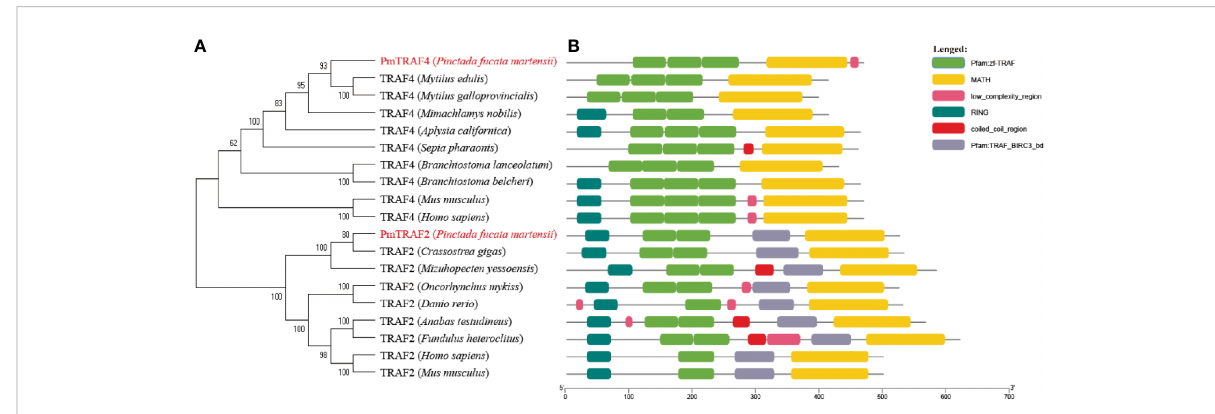
FIGURE 3 Phylogenic analysis (A) and protein domain information (B) of PmTRAF2 and PmTRAF4. The GenBank accession numbers of TRAF4 ortholog